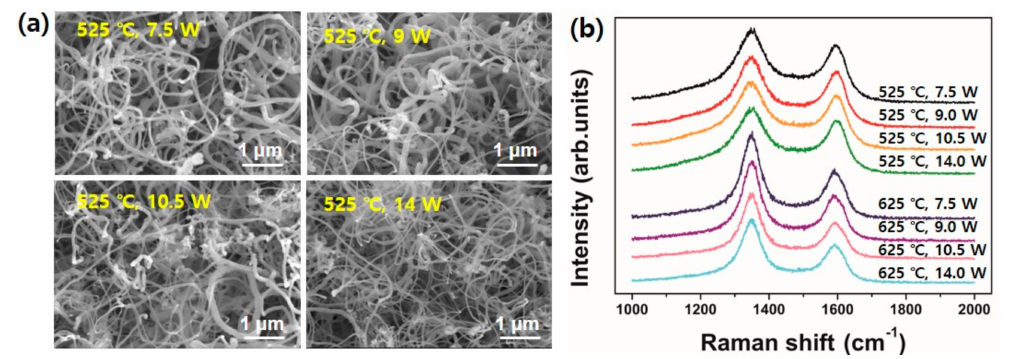
Figure 6. ( a ) SEM images showing the di ff erent morphologies of CNT grown at specified plasma power.